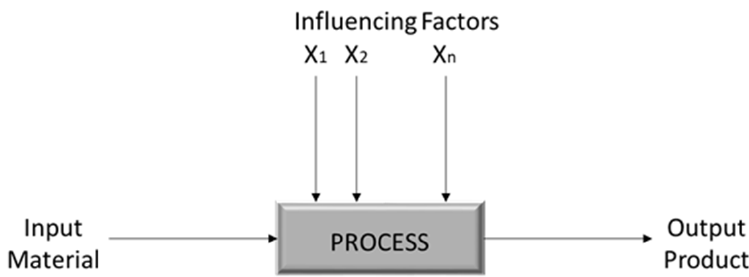
Figure 3. Schematic process of Minitab.